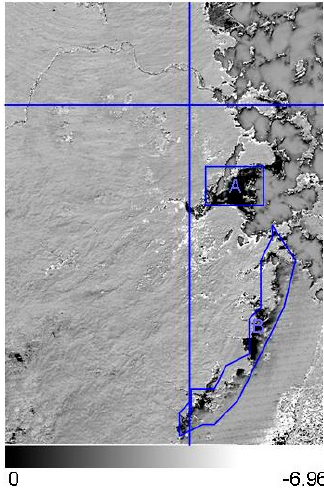
Figure 5. The difference between Figures 3 and 4. Atmosphere 2017 , 8 , 139